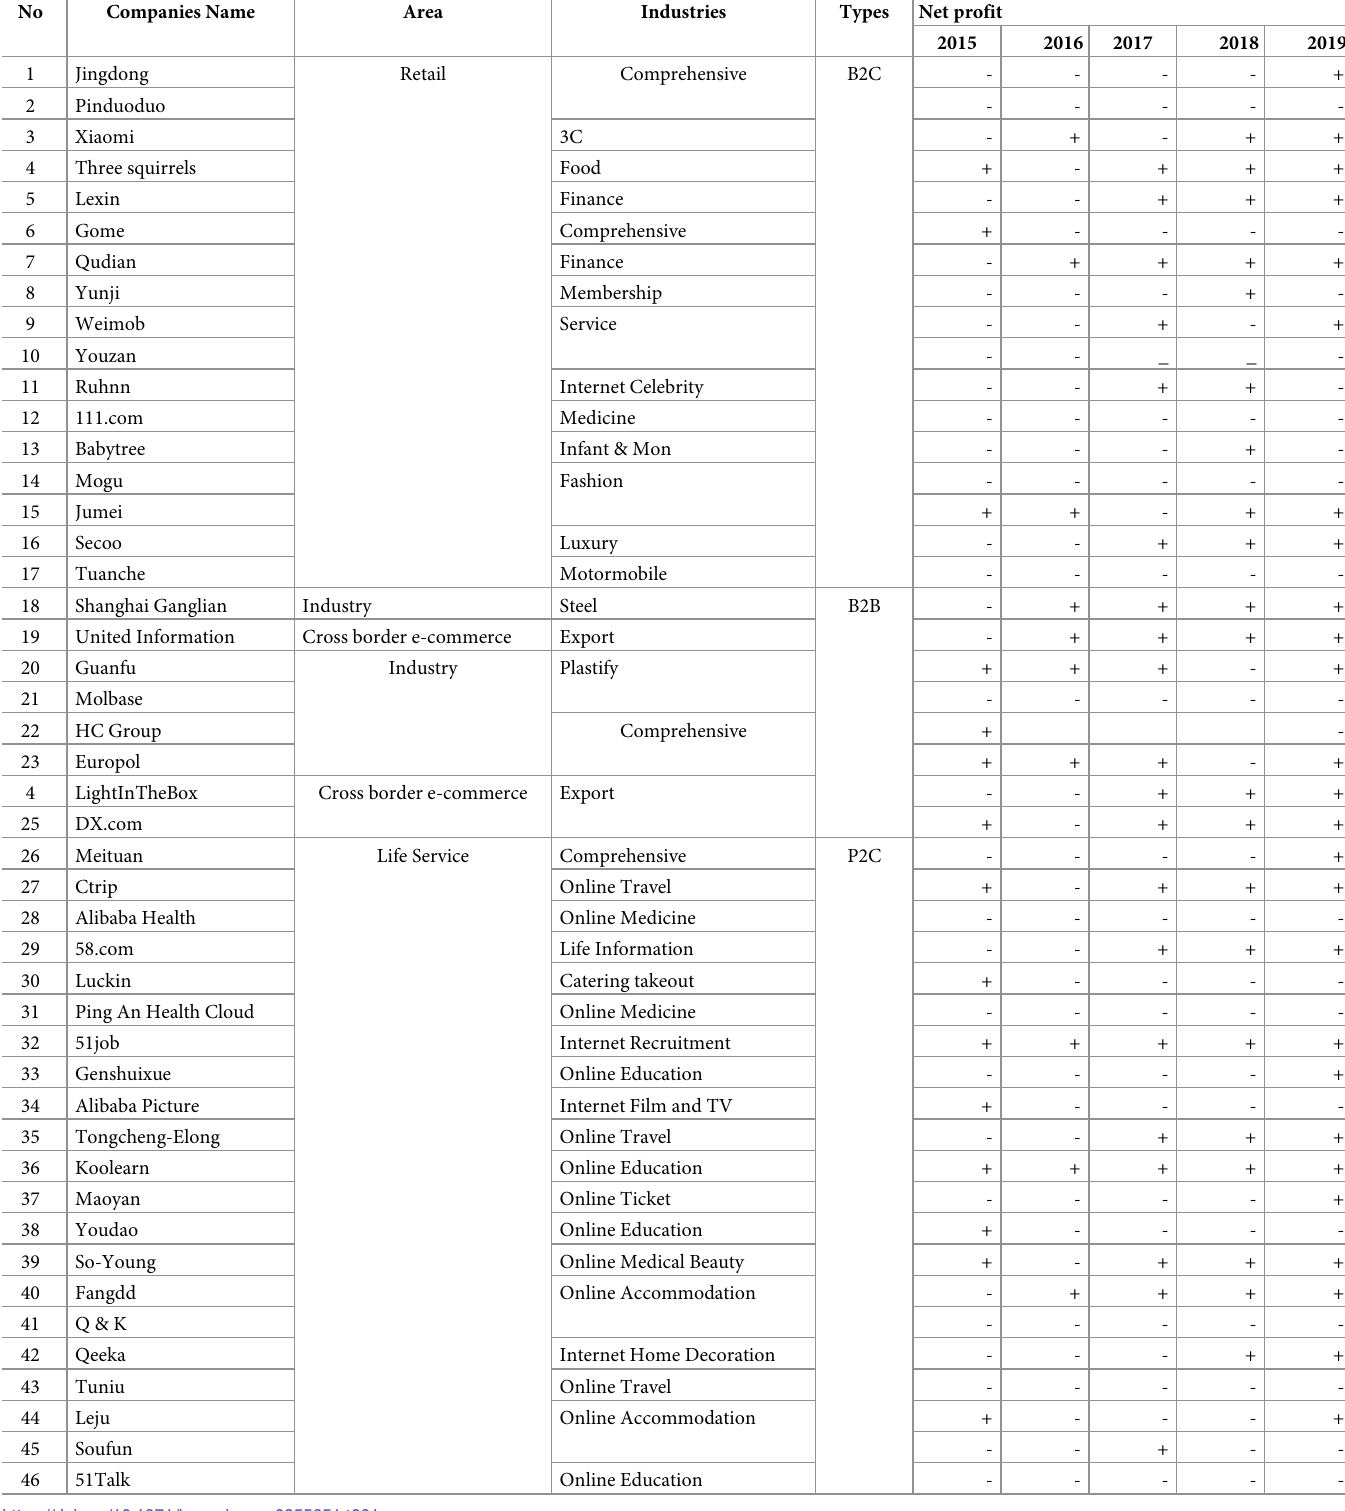
Table 1. Positive and negative firm